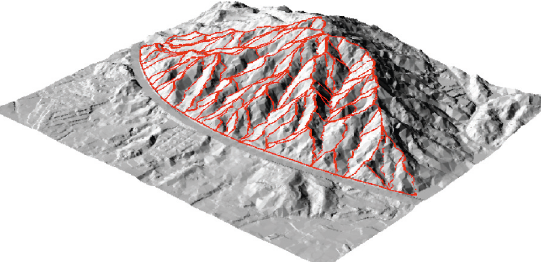
Figure 10: Slope unit division of the study